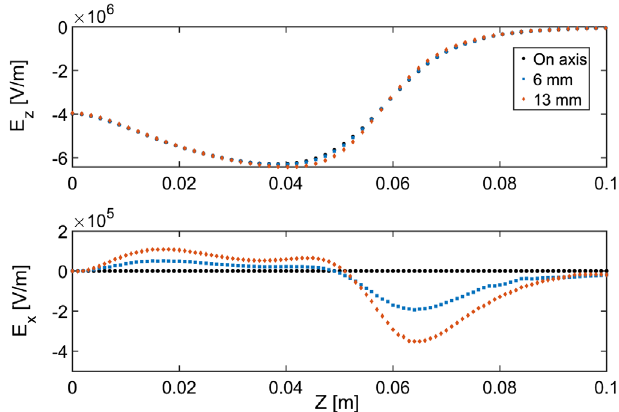
FIG. 5. Longitudinal (E z ) and transverse (E x ) electric fields along the beam path for various anode offsets. The plotted E x field is what is experienced by the center of the beam as it is passes the dc